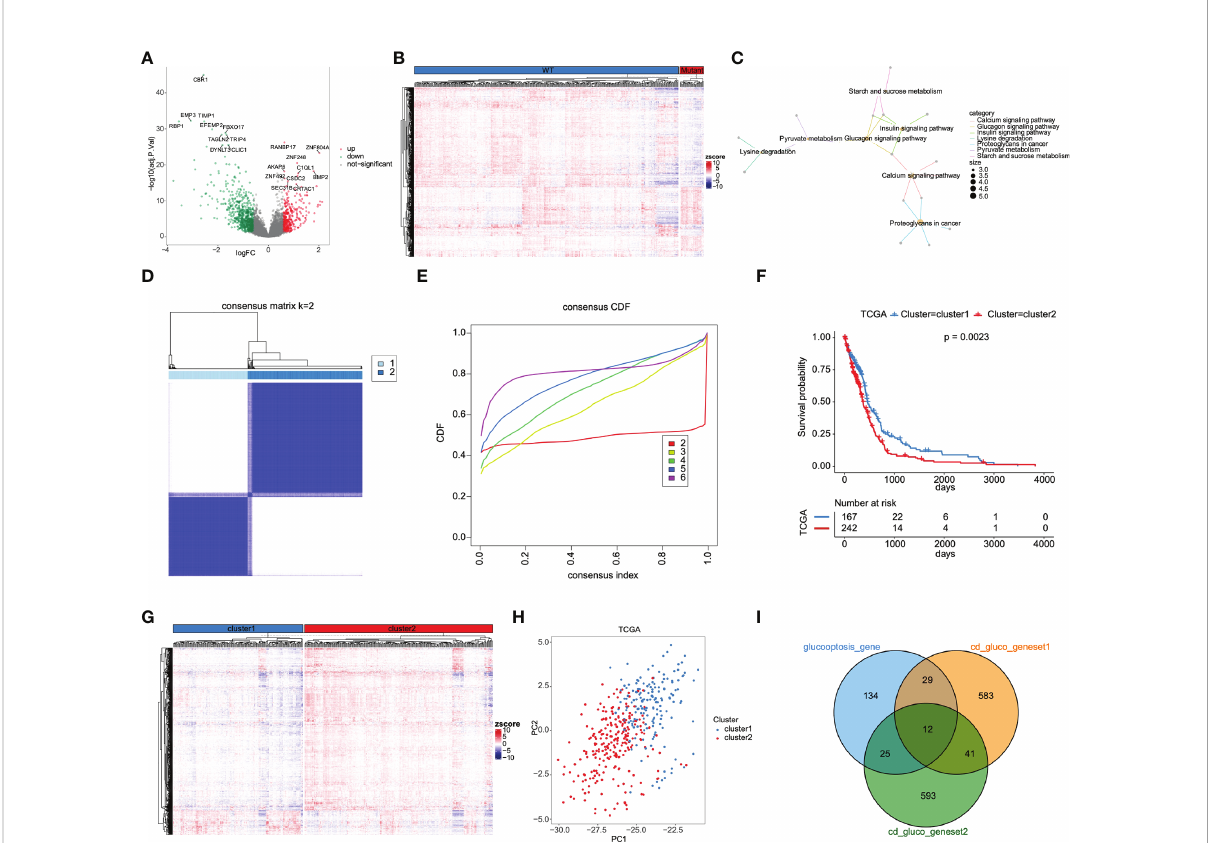
FIGURE 2 Determination of GRG set based on DEGs between IDH MUT and WT GBM. (A) The volcano plot for DEGs between IDH MUT and WT GBM from the TCGA database. (B) Heatmap of DEGs expression levels. (C) KEGG functional enrichment analysis of 37 differentially expressed GRGs. (D) 409 GBM samples were classi fi ed into two subtypes according to 37 differentially expressed GRGs, named cluster 1 and cluster 2. (E) Consensus cumulative distribution function. (F) Kaplan-Meier survival curves for cluster 1 and cluster 2 subtypes. (G) Heatmap of DEGs between cluster 1 and cluster 2 subtypes. (H) Cluster 1 and cluster 2 are clearly distinguished using principal component analysis (PCA). (I) Construction of a whole new GRG set (1417